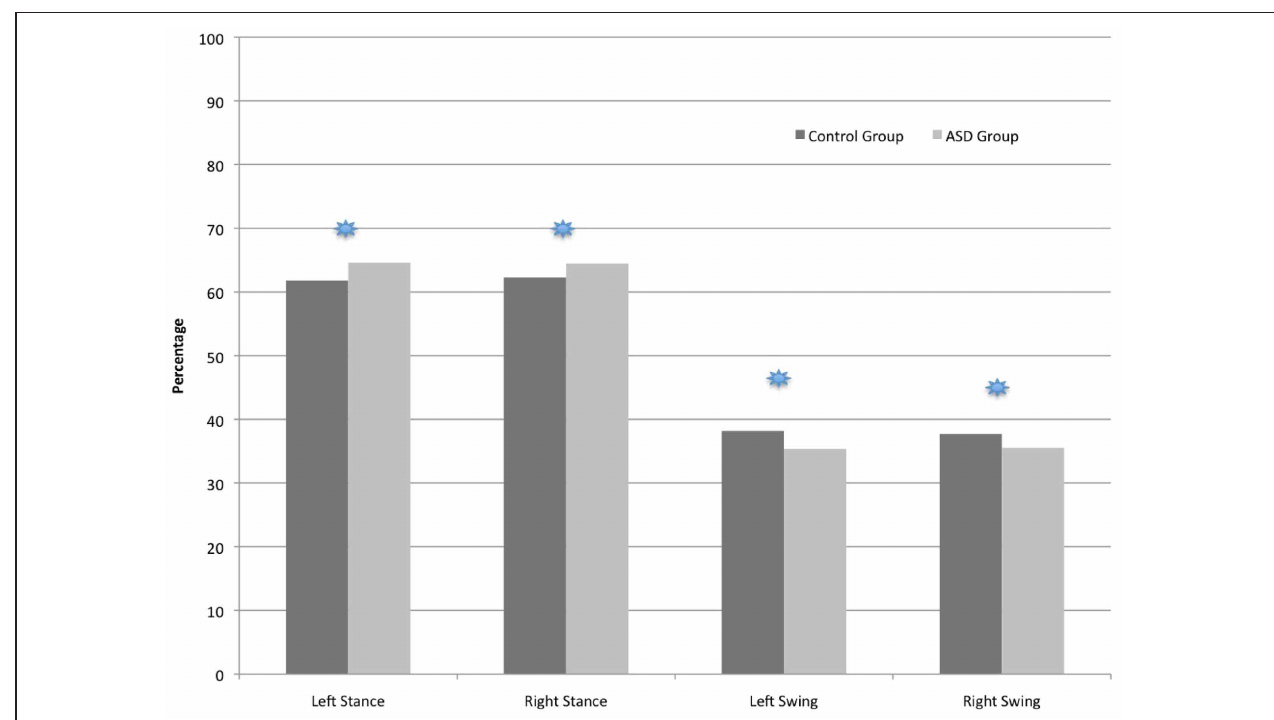
FIGURE 2 | Comparison of the two groups in the percentage of time spent in the Stance and Swing Phases of the Gait Cycle. p < 0 . 001 ( ).